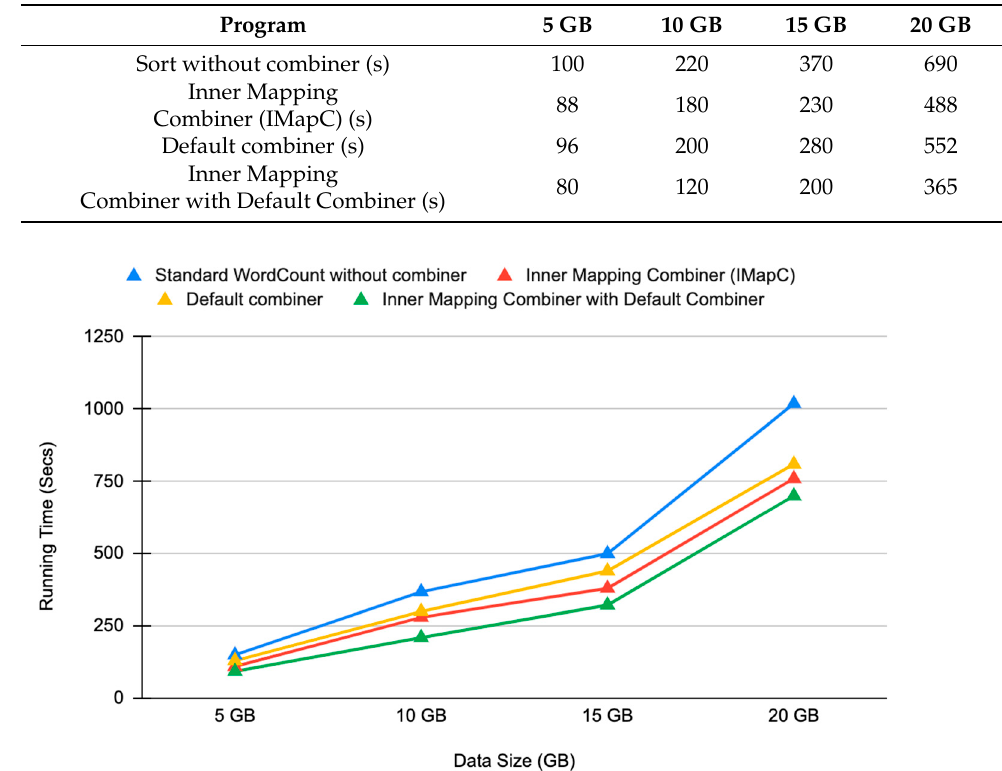
Figure 6. The execution time of the WordCount program for Inner Mapping Combiner (IMapC) over Default Combiner and without Combiner in TFR.